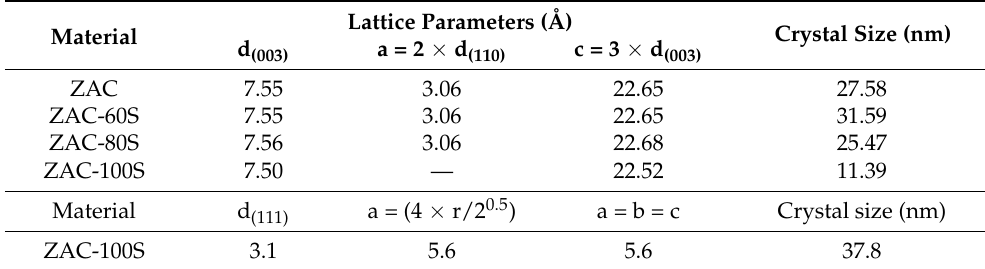
Table 1. Crystalline information for the samples, types ZnAl-LDH and